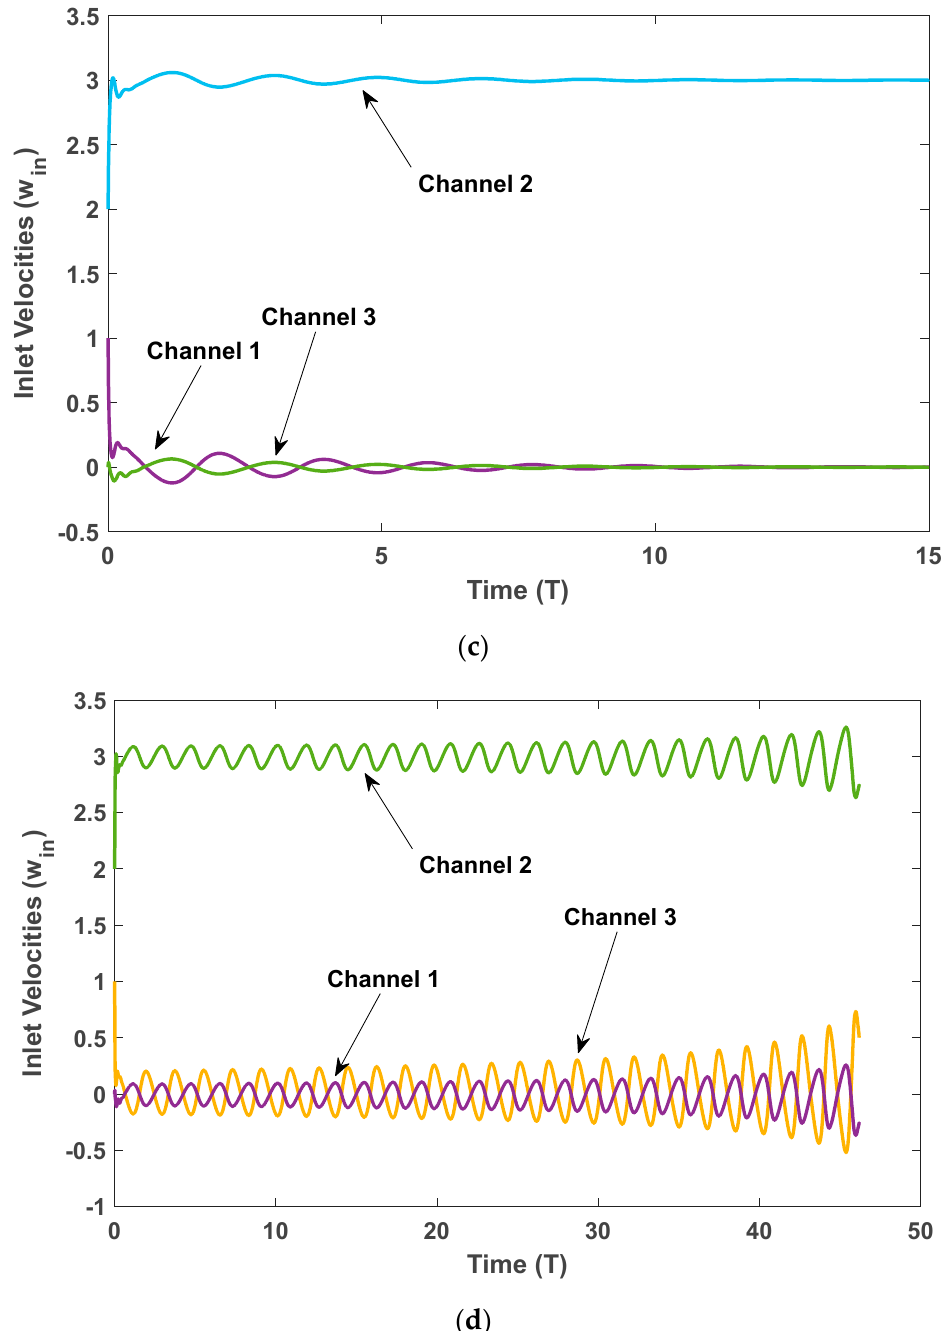
Figure 10. Numerical simulation at different parametric values. ( a ) On the stability boundary. ( b ) On the unstable side of the stability boundary. ( c ) On the stable side of the stability boundary, when system experiences small perturbation. ( d ) Subcritical Hopf bifurcation, at large perturba- tion.